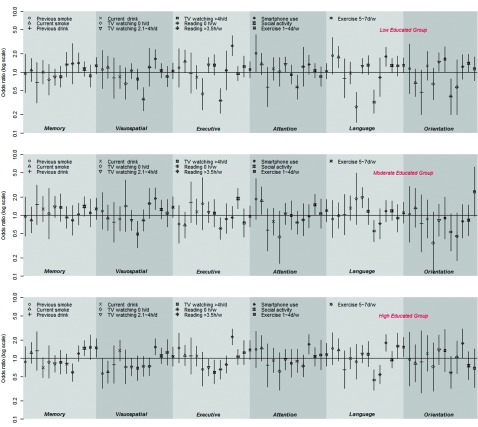
Odds ratios and 95% confidence intervals for better cognitive functions in six domains among three education-specific groups. Proportional odds models were adjusted for background factors (age, gender, area, education, marital status), and medical and health factors (BMI, hypertension, diabetes, depression) in all models. Symbols represent the point estimates (ORs) while vertical bars around the symbols are the corresponding 95% CIs. Reference groups: Cigarette: never smoke; Alcohol: never drink; TV watching: 0.1~2h/d; Reading: 0.1~3.5h/w; Smartphone use: no; Social activity: no; Exercise: 0d/w.